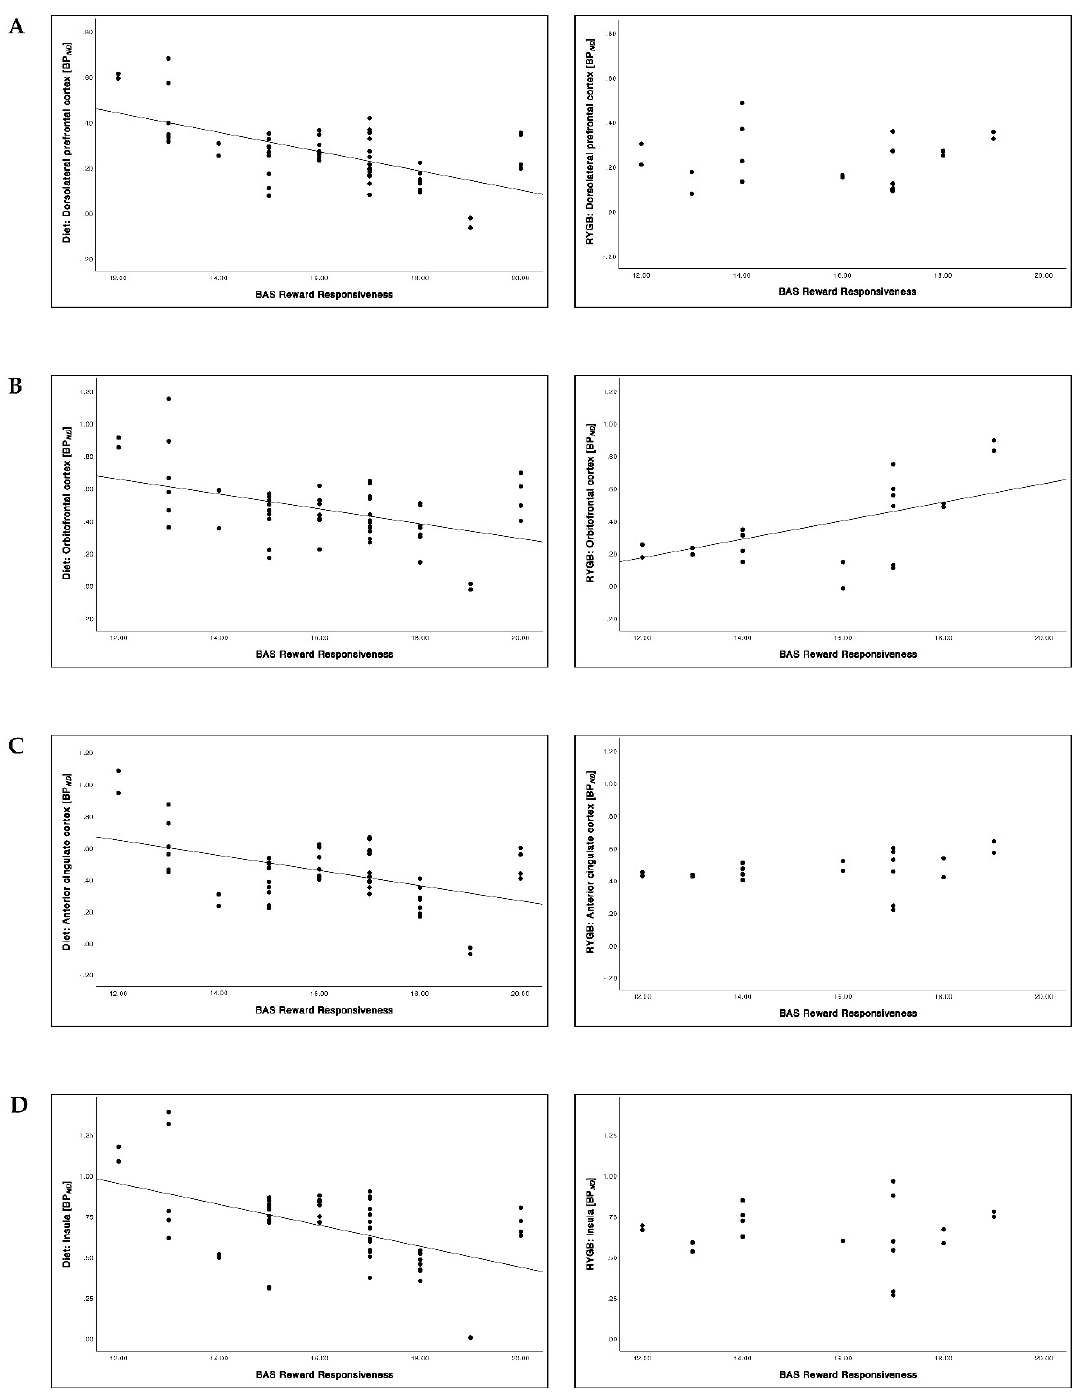
Figure 9. Relationship between BAS reward responsiveness and 5-HTT BP ND in the dorsolateral prefrontal cortex (dlPFC) ( A ), the orbitofrontal cortex (OFC) ( B ), the anterior cingulate cortex (ACC) ( C ) and the insula ( D ) after 6 months of intervention (at